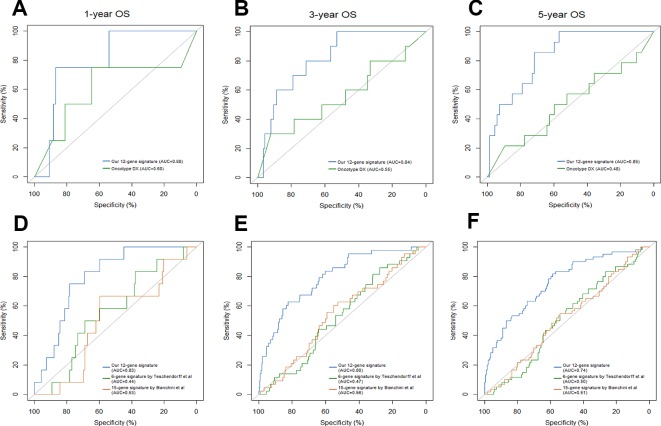
Comparison of our 12-gene signature and other models. Time-dependent ROC analysis was performed to compare our 12-gene signature and Oncotype Dx in predicting 1-year (A), 3-year (B) and 5-year (C) overall survival (OS). Time-dependent ROC analysis was performed to compare our 12-gene signature and other two immune-related signatures in predicting 1-year (D), 3-year (E) and 5-year (F) overall survival (OS).